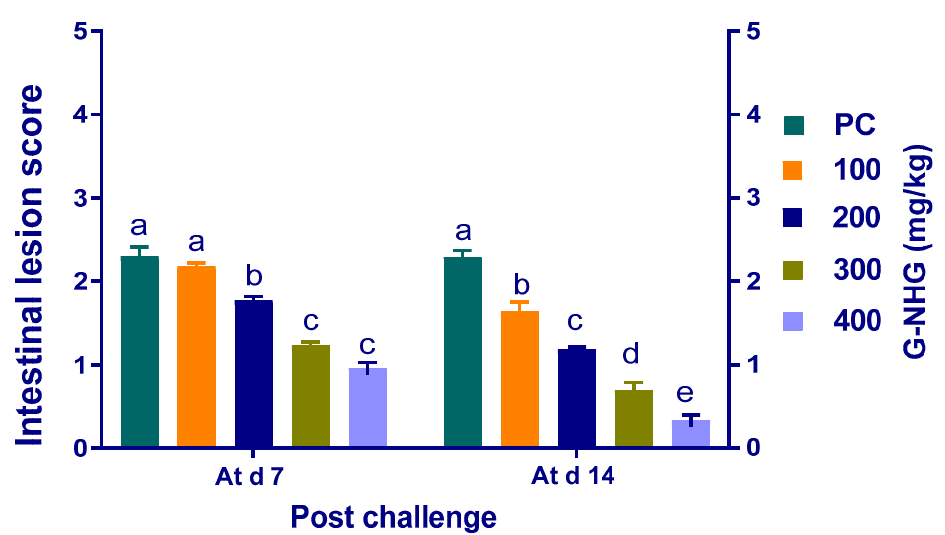
Figure 4. Effects of dietary supplementation with different levels of G-NHG on lesion score in the small intestine of broiler chickens at 7 and 14 d post challenge with C. perfringens . Values are means with their SE in bars. PC (positive control): birds fed a basal diet and challenged with C. perfringens , G-NHG (100, 200, 300 or 400 mg/kg)-treated groups: birds fed a basal diet supplemented with 100, 200, 300 or 400 mg/kg of garlic nanohydrogel and challenged with C. perfringens . a–e Means within the same column carrying different superscripts are significantly different at p < 0.05.